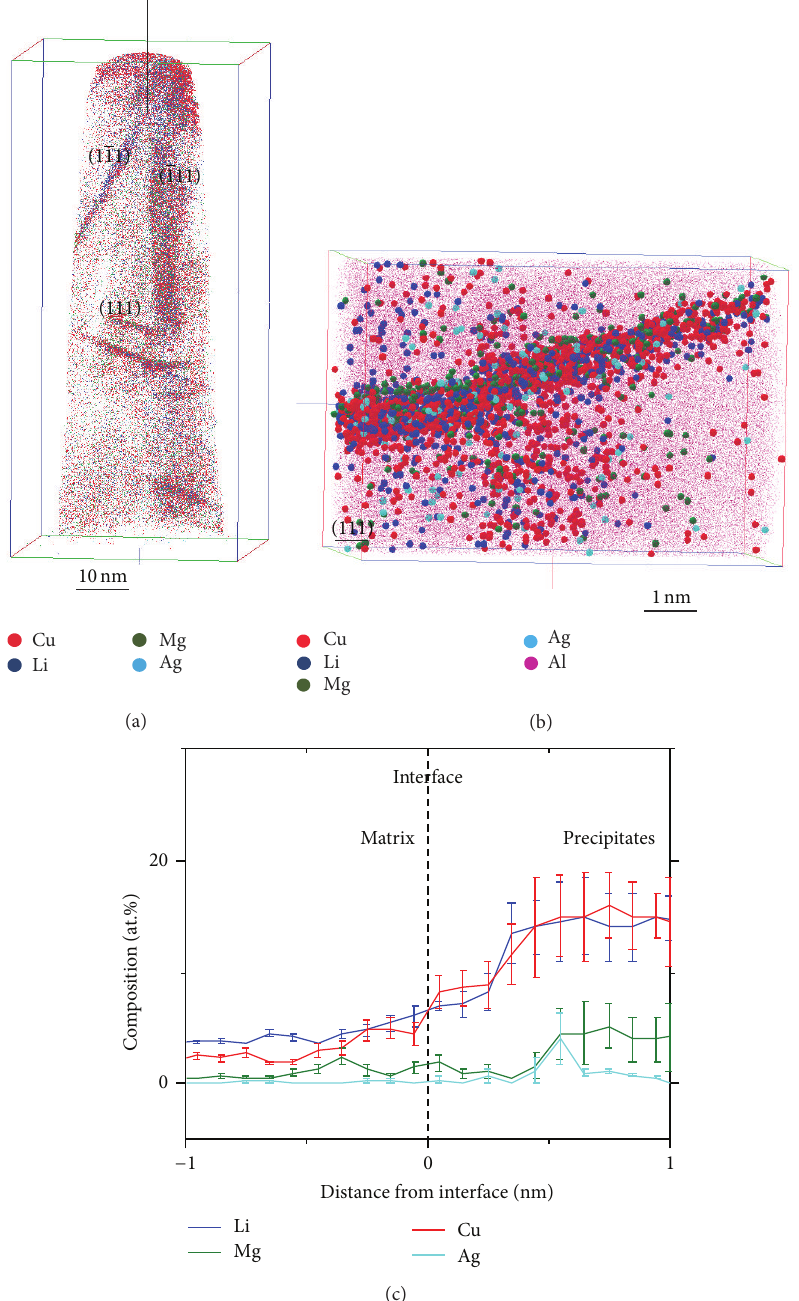
Figure 4: LAWATAP analysis for the specimen with rolling texture with the same experimental parameters as in Figure 3. (a) Reconstructed volume showing three out of four orientations of the T 1 precipitate on the {111} matrix planes. (b) Magnified view of the T 1 platelet with resolved {111} planes reveals the distribution of Mg within the T 1 platelet. (c) Corresponding proxigram composition profile for the T 1 platelet on the {111} plane gives the chemical composition as ( 14 ± 2 ) at.% Cu, ( 14 ± 3 ) at.% Li, ( 4 ± 1 ) at.% Mg, and ( 1.4 ± 0.4 ) at.%